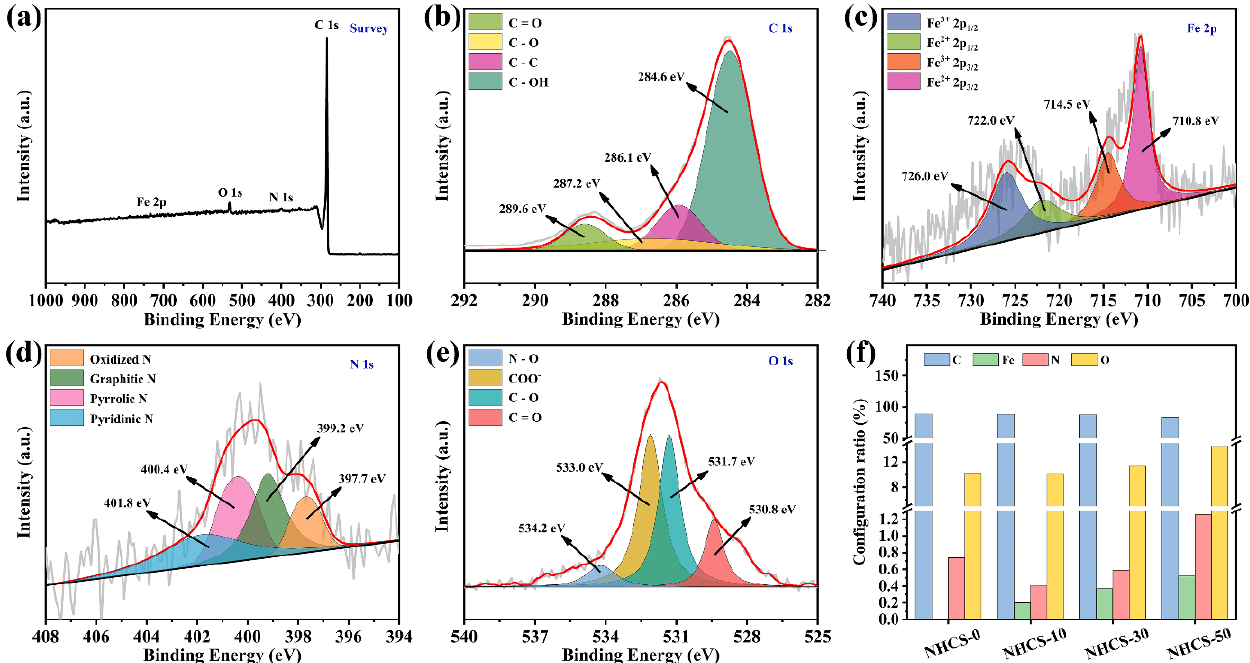
Figure 4. ( a ) XPS survey spectrum and ( b – e ) high-resolution C 1s, Fe 2p, N 1s, and O 1s regions, respectively, of NHCS- 30; ( f ) Histogram of relative contents for different elements.